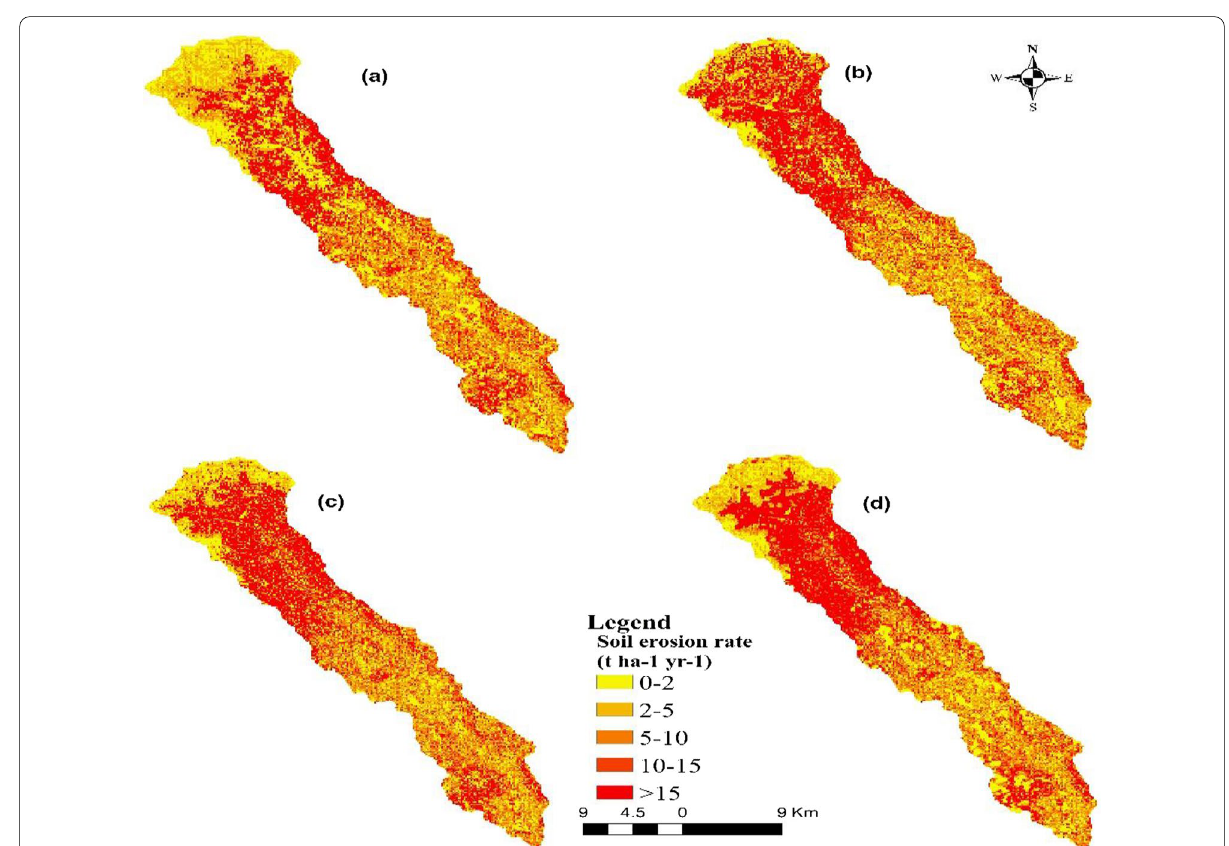
Fig. 7 Estimated annual soil loss map of the study area in 1985 ( a ), 2002 ( b ), 2017 ( c ), and 2033 ( d